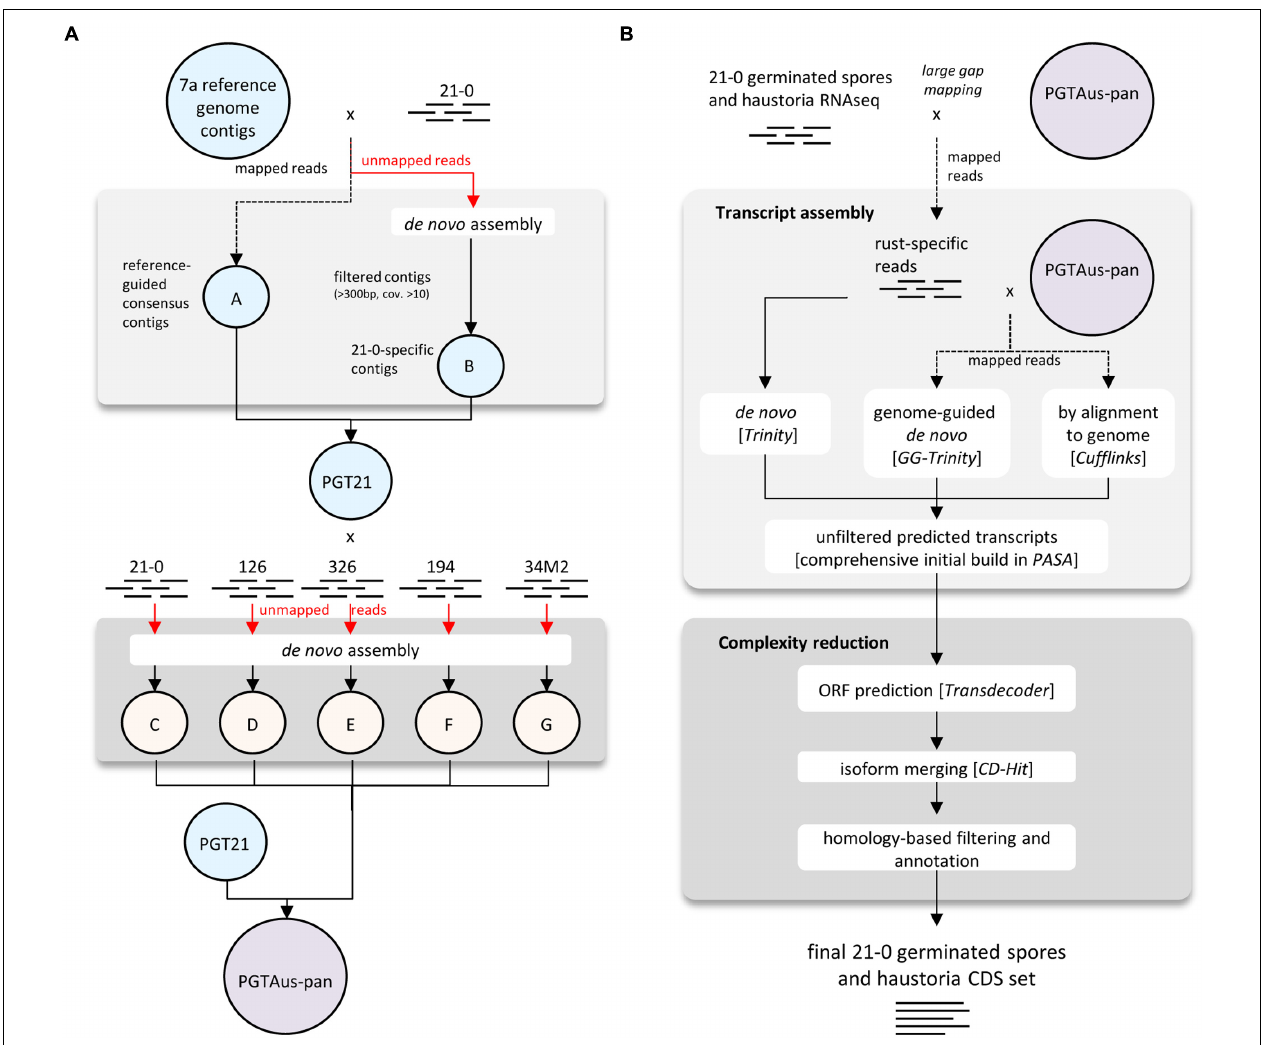
FIGURE 1 | Flow chart diagrams illustrating genome and transcriptome assembly pipelines. (A) Pipeline for assembly of PGT21 and PGTAus-pan genomes from DNA reads from Australian Pgt isolates. (B) Pipeline for assembly of isolate 21-0 transcriptome from RNA reads from isolated haustoria and germinated